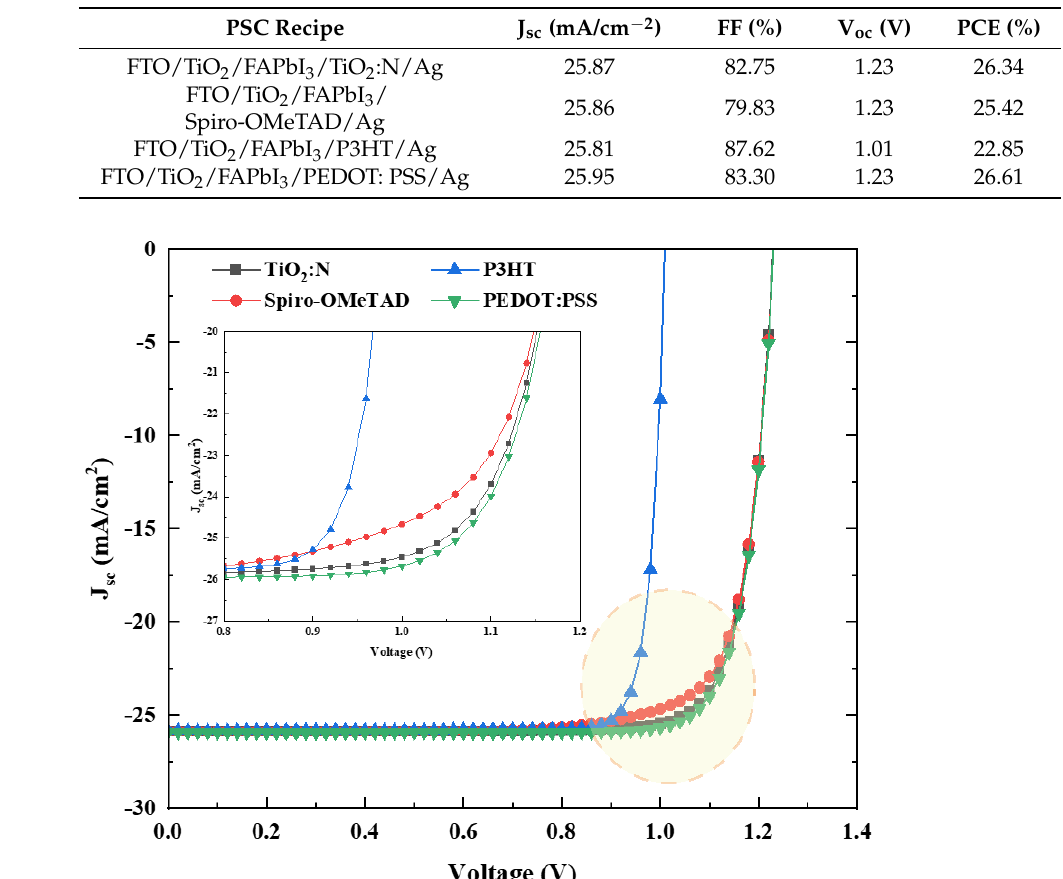
Table 8. Performance parameters attained from the HTL comparative analysis.